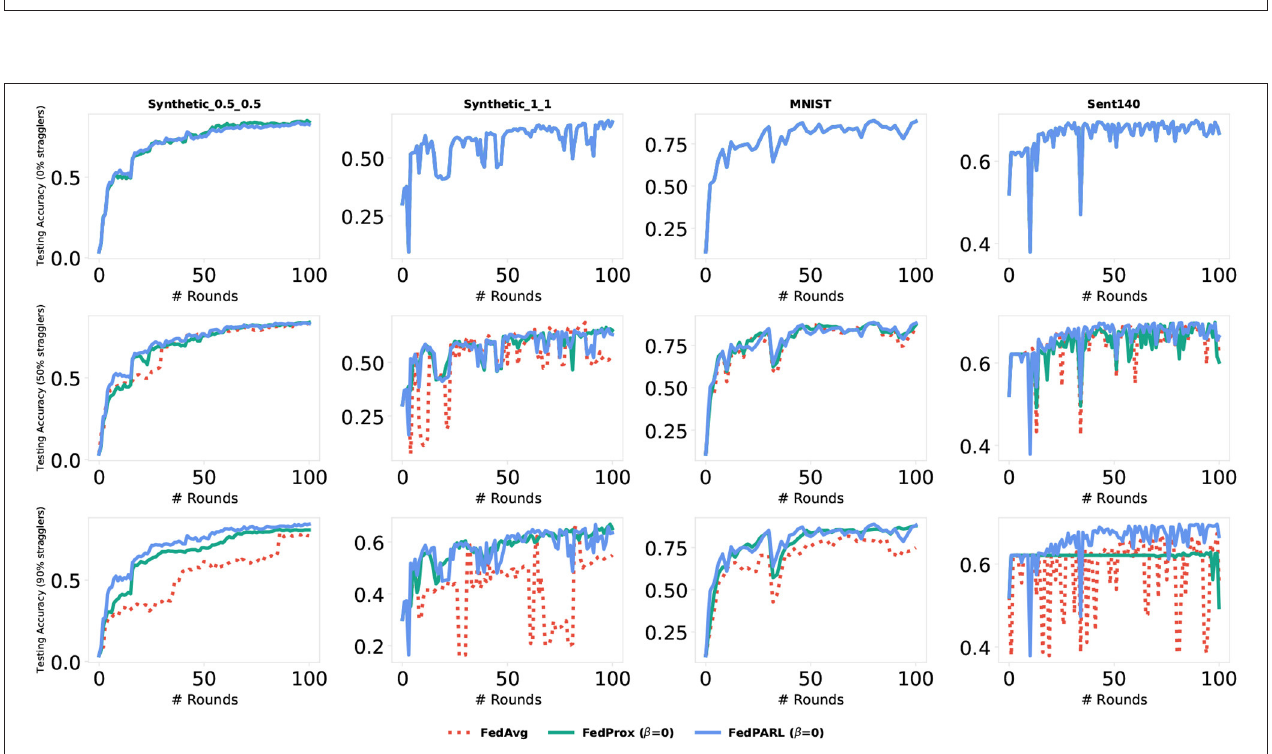
FIGURE 10 | Comparison of training loss of our proposed FedPARL framework (considering no proximal term, i.e., β of different percentages of stragglers (i.e., 0, 50, and 90%).